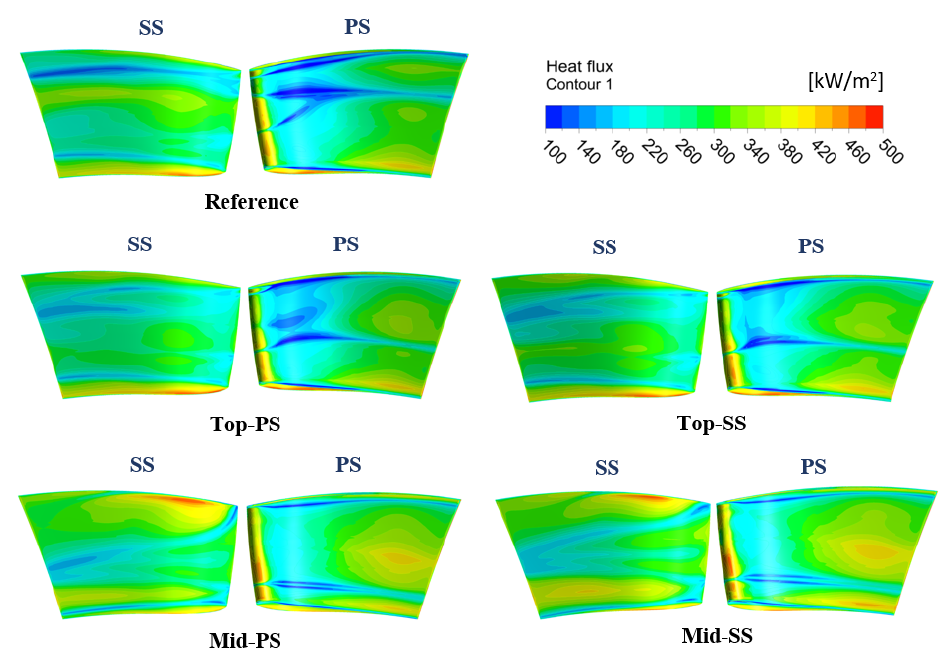
Figure 16. Heat flux distribution on the S 2 vanes surface under various blade conditions.